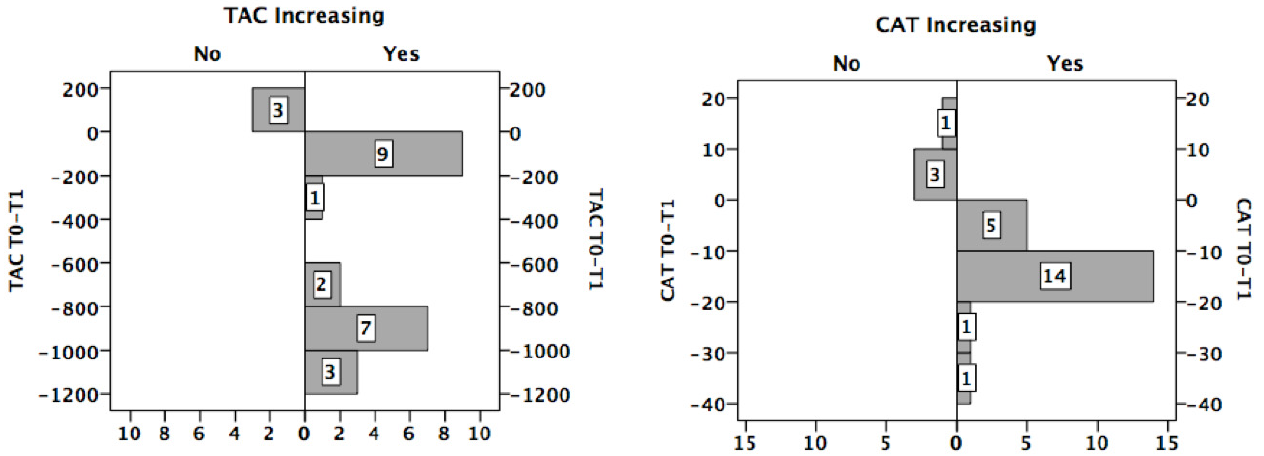
Figure 2. Number of patients who increased (Yes) or not (No) their total antioxidant capacity/catalase